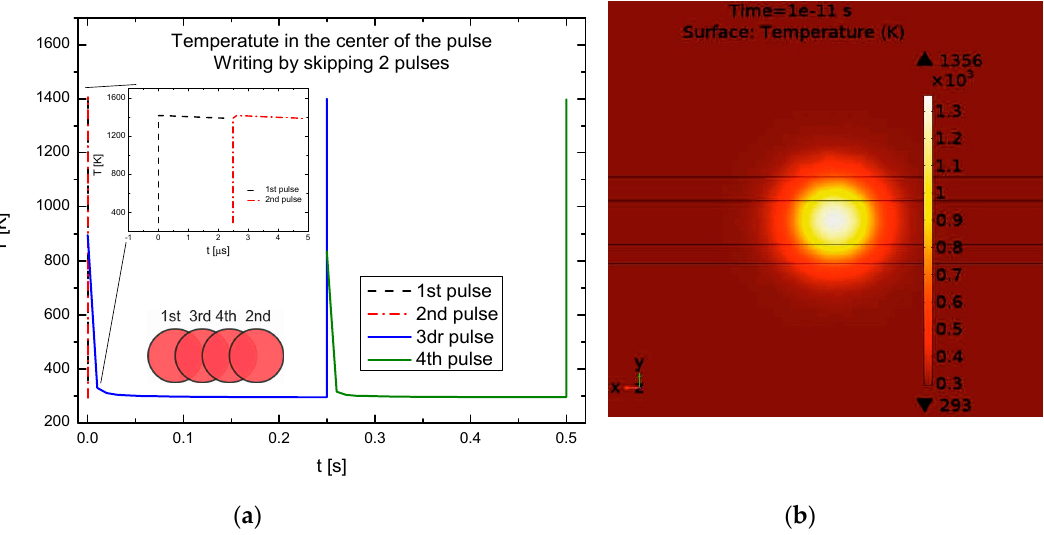
Figure 4. The transient temperature model for scanning type of X1D: ( a ) in the centre of the pulse; ( b ) the temperature distribution in K on the surface after 4th pulse.